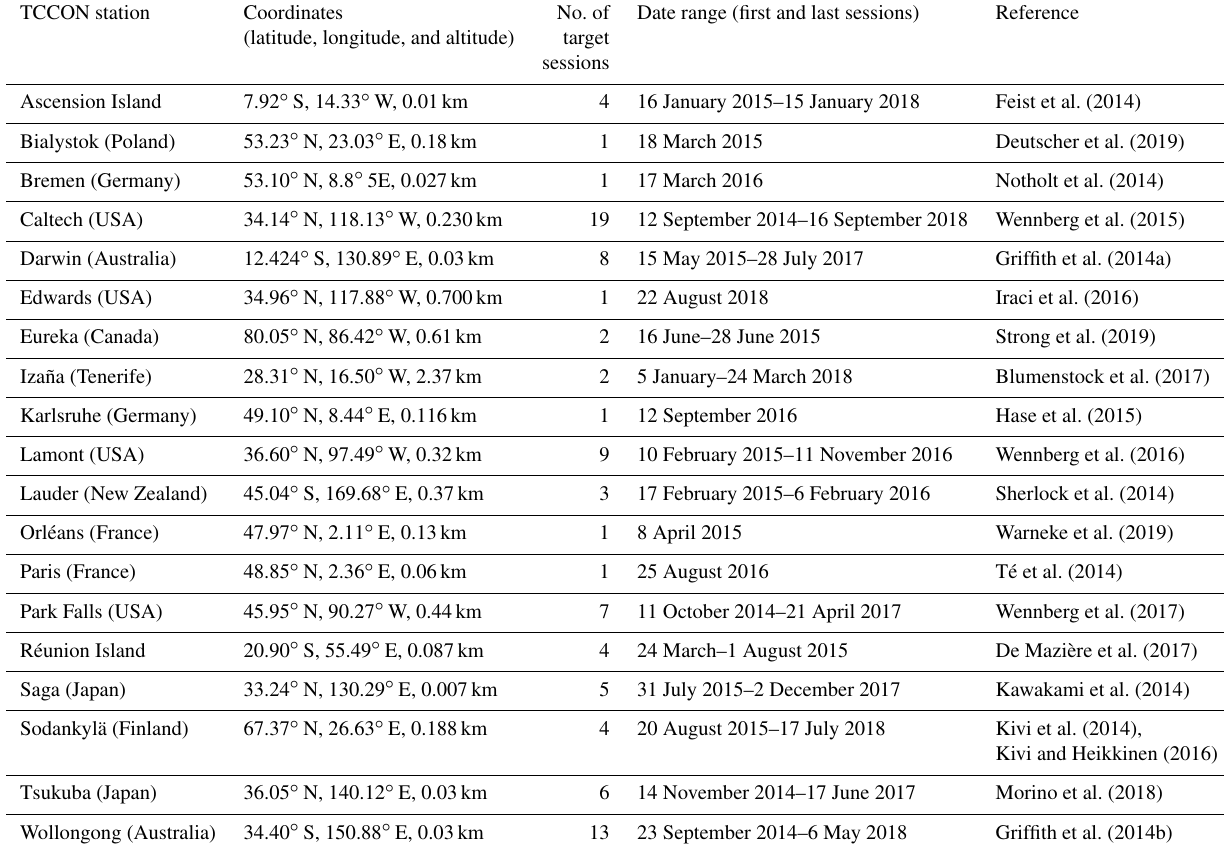
Table 2. TCCON data used in this